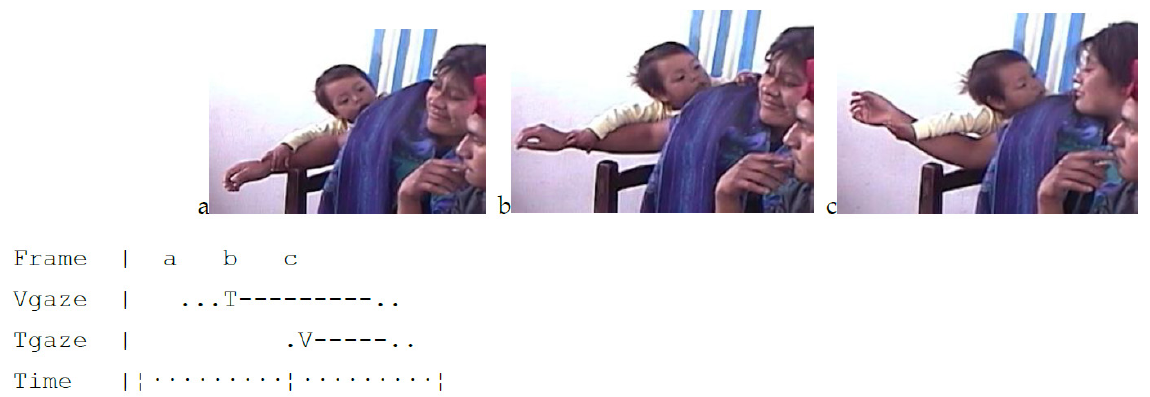
Figure 7. Vic at 12 mos. called for attention by sound, touch, and gaze. ( a ) Vic sought the visual attention of his aunt, although it never became clear what “content” he might want to convey other than getting her to attend to him. Vic moved from staring at his uncle Frank, ( b ) to turning his gaze to Terry and placing his hand on her shoulder, and then ( c ) engaging in a mutual gaze with Terry when she turned to look at him.